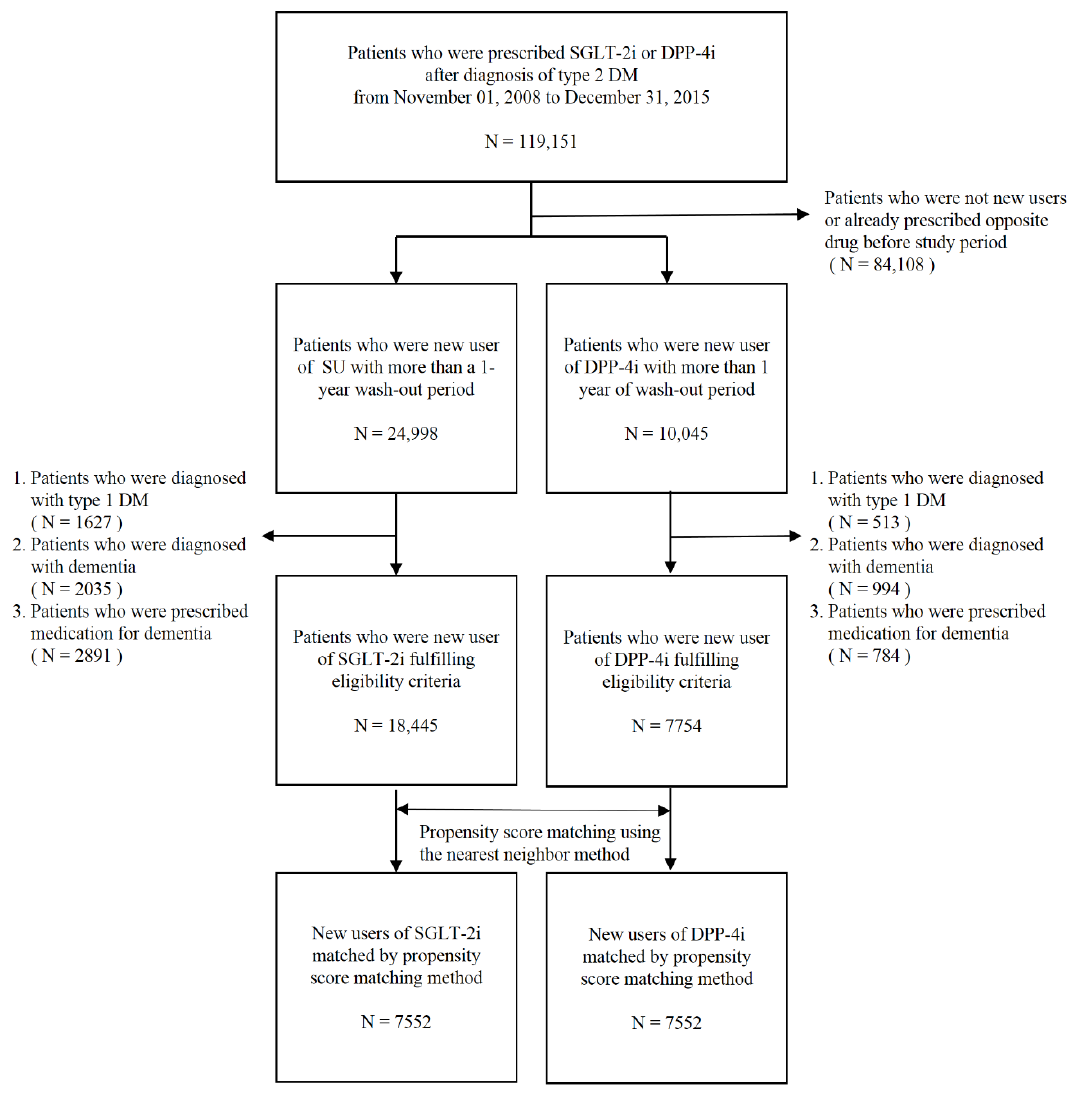
Figure 1. Flow chart of the sample selection process. DM, diabetes mellitus; DPP-4i, dipeptidyl-peptidase IV inhibitor; N, number; SGLT-2i, sodium-glucose co-transporter 2 inhibitor; SU, sulfonylurea.